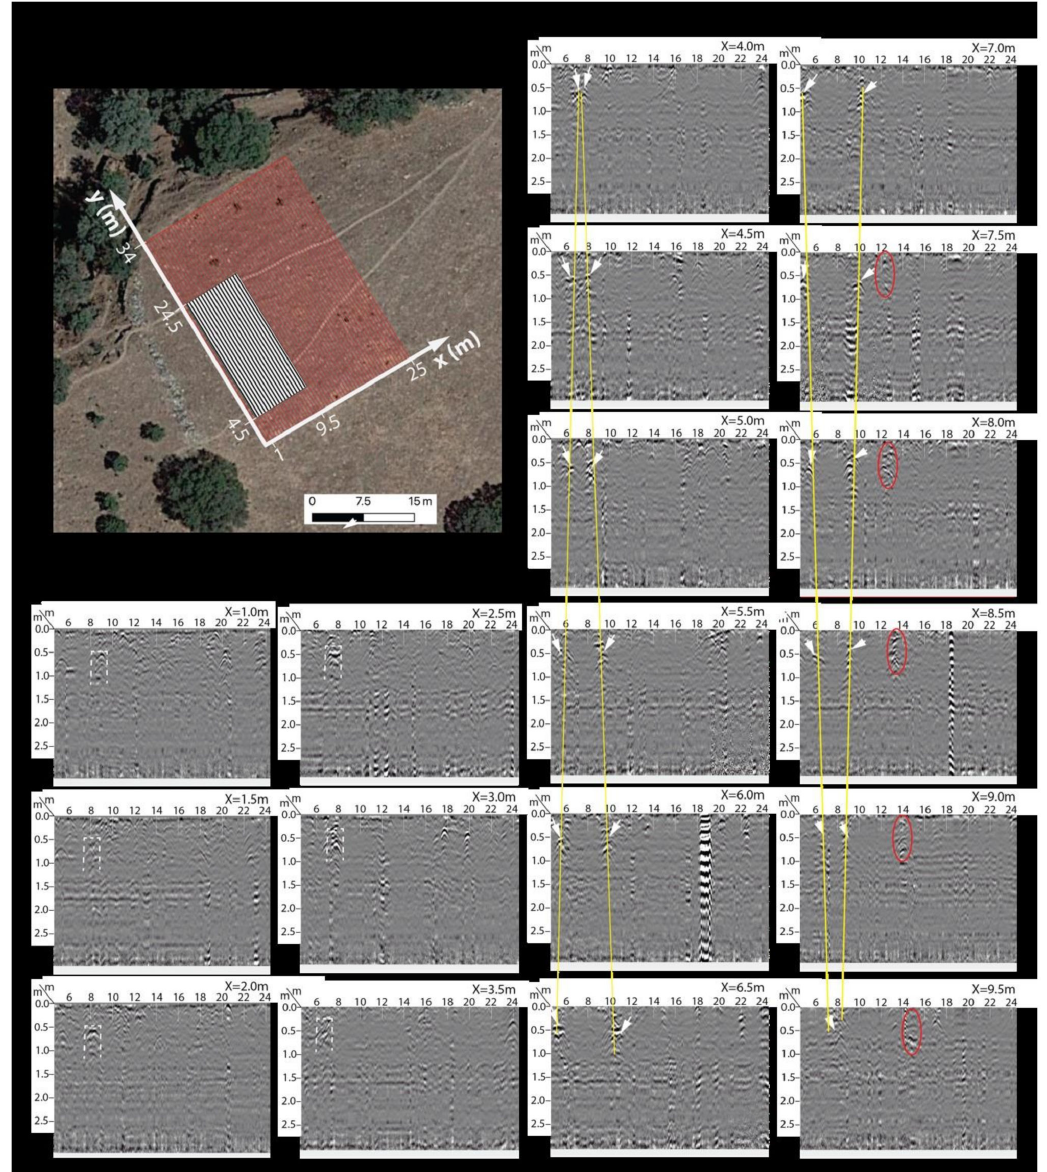
Figure 7. Top left corner: location of the surveyed GPR grid (profiles 0.5 m apart), where the segments of the profile analysed in this work are marked with black lines over a white rectangle. Remaining parts of the figure: the 18 processed GPR sections from the analysed area. On the radargrams some reflectors with lateral continuity across adjacent profiles are